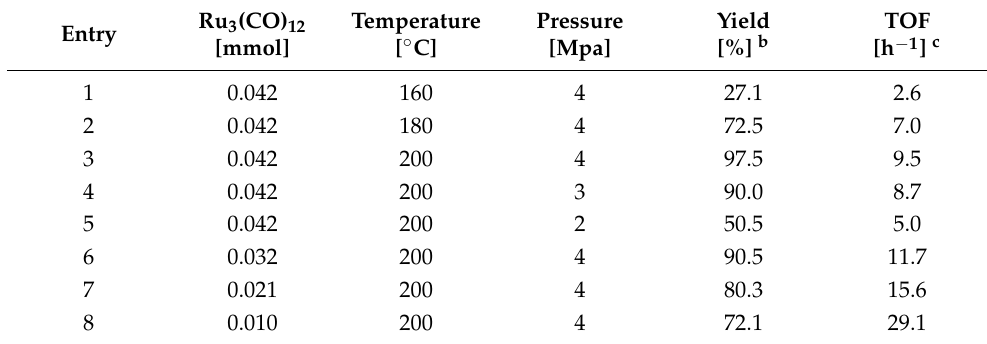
Table 3. Yield of MPA under different conditions on hydroesterification reaction a .